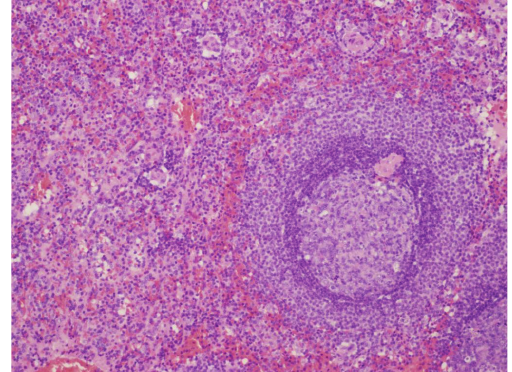
Figure 2: Splenic nodule showing white pulp composed of lymphoid aggregates with eccentric arterioles surrounded by red